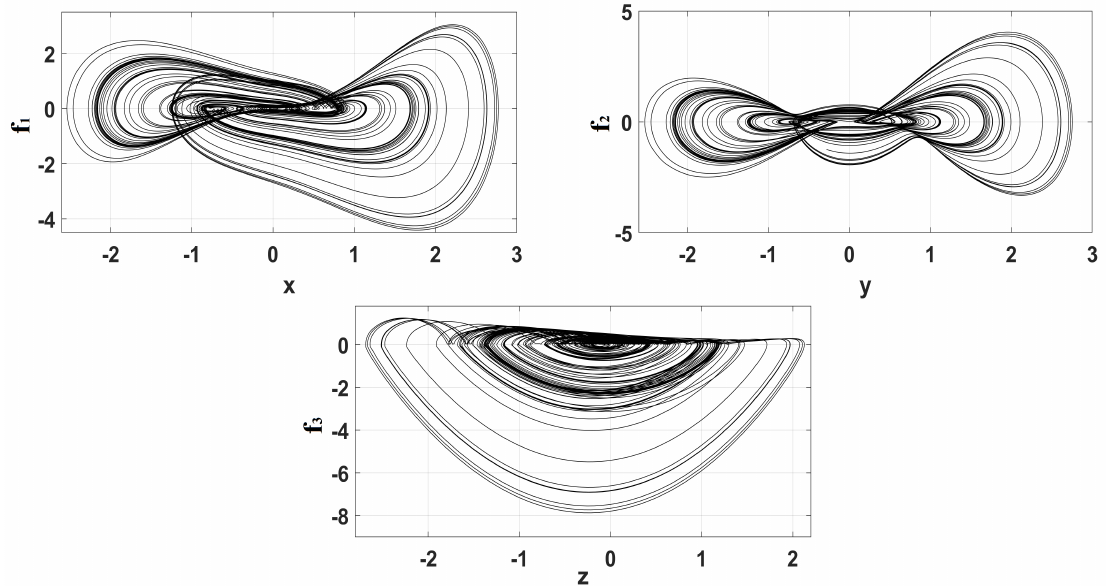
Figure 4. Phase portraits of system (1) for each state versus its derivative, for a = 0.65 and b = 0.1 and x ( 0 ) = ( 0,0.1,0.1 ) , for 1500